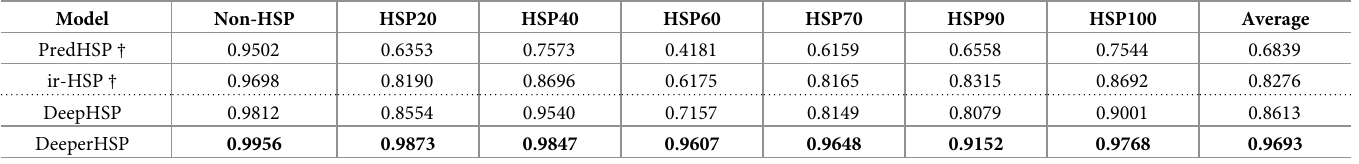
Table 5. Comparison of class-wise classification performance in terms of F1 score using 5-fold cross-validation. Model